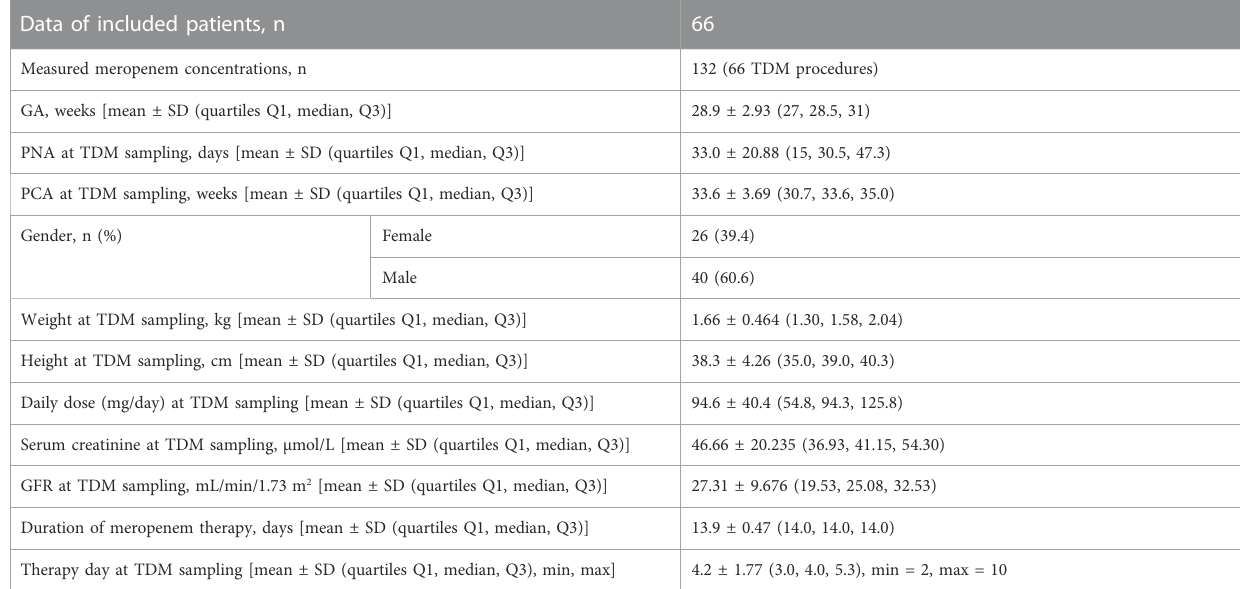
TABLE 1 Descriptive statistics for demographic and clinical characteristics. Data of included patients,